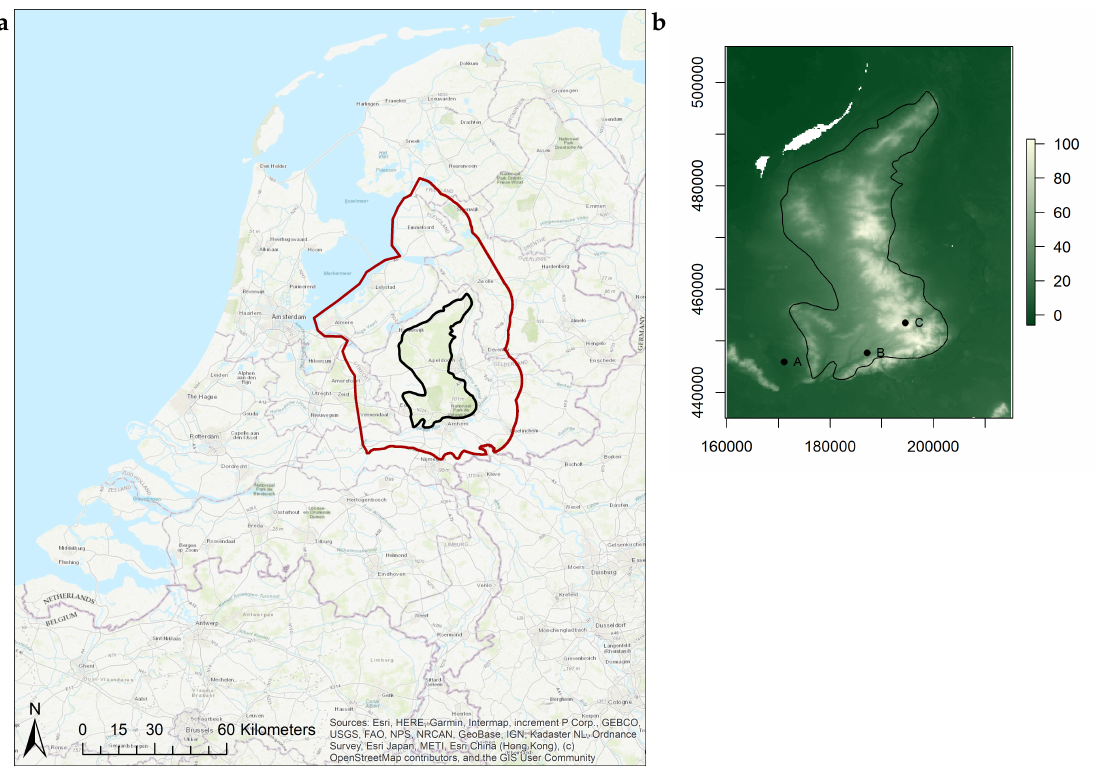
Figure 1. ( a ) Location of the Veluwe area in The Netherlands. The domain of the groundwater model is indicated in red, the Veluwe area in black. ( b ) Elevation (m a.s.l.) of the Veluwe area. Veluwe area is indicated in black and locations of the time series with letters (A: 171154,445864; B: 187208,447643; C: 194583,453461).